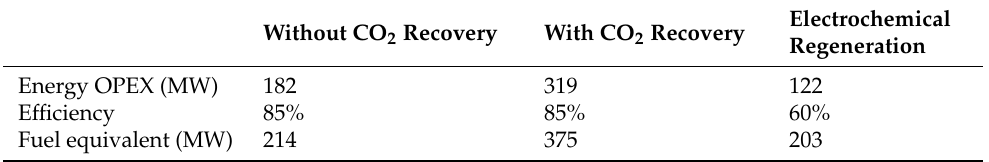
Table 5. Comparison between the two base cases and electrochemical